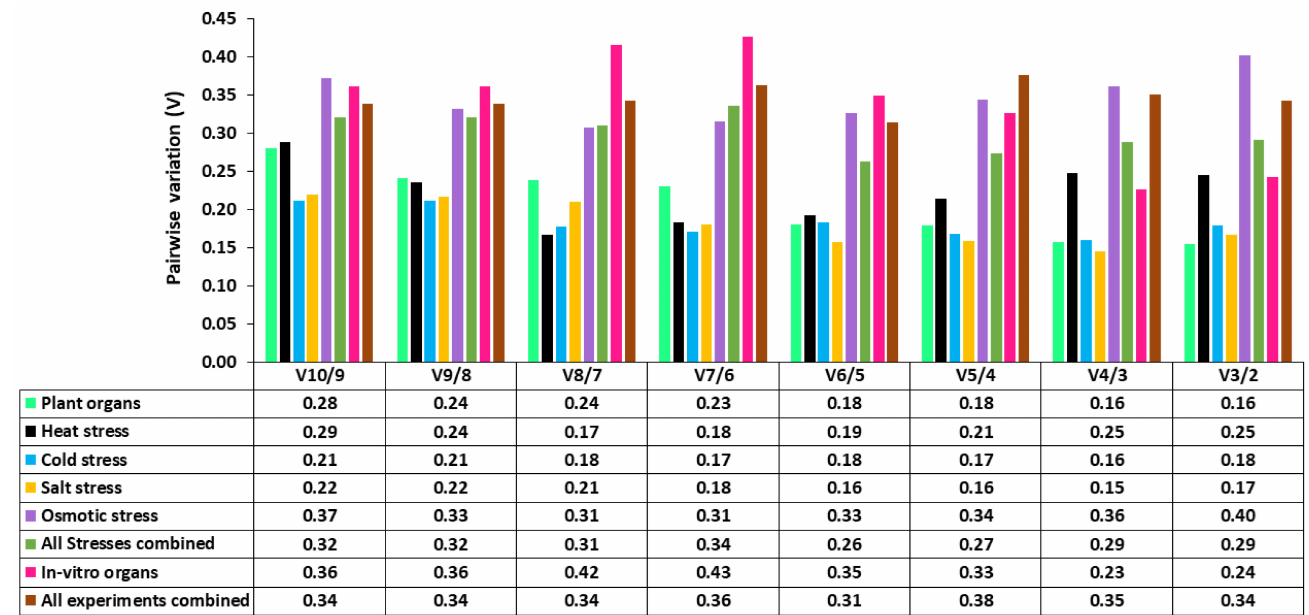
Figure 5. Pairwise variation to determine the optimal number of reference genes. The recommended cutoff value under which there is no need for another gene is 0.15.